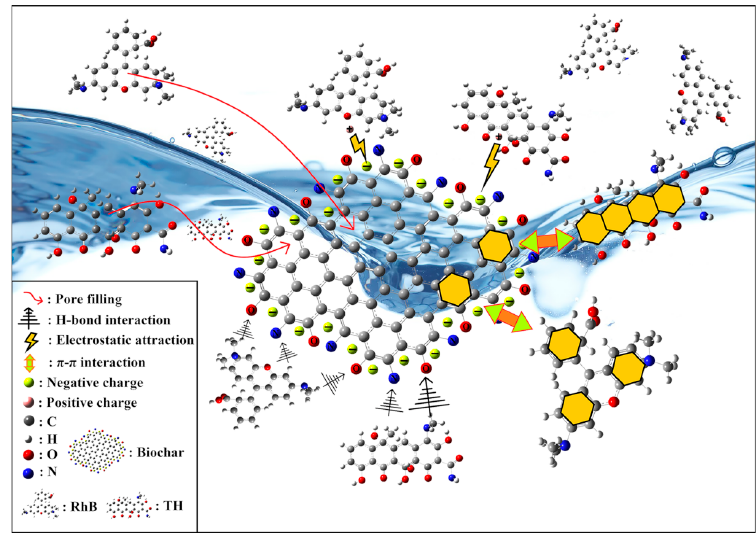
Figure 10. Probable mechanisms of MITGB for removal of organic pollutants.